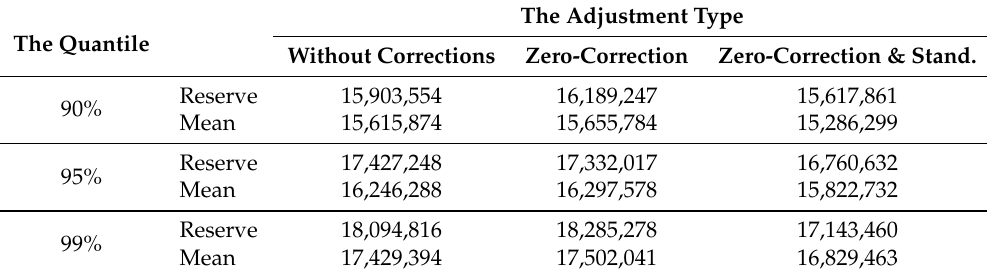
Table 10. The upper confidence limits for the total reserve and for the mean of the total reserve by the Poisson model and the Anscombe